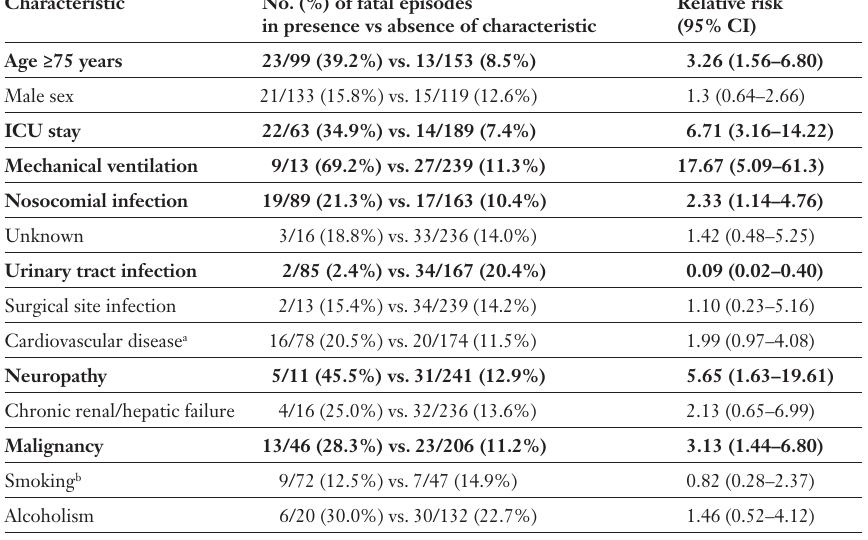
Univariate analysis of risk factors for fatal outcome of bloodstream infec- tion in 252 non- diabetic